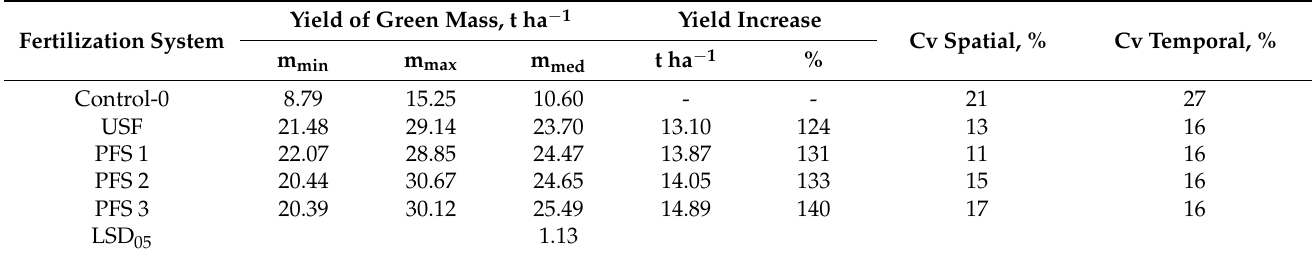
Table 7. Agronomic efficiency of fertilization systems on perennial grasses (average for